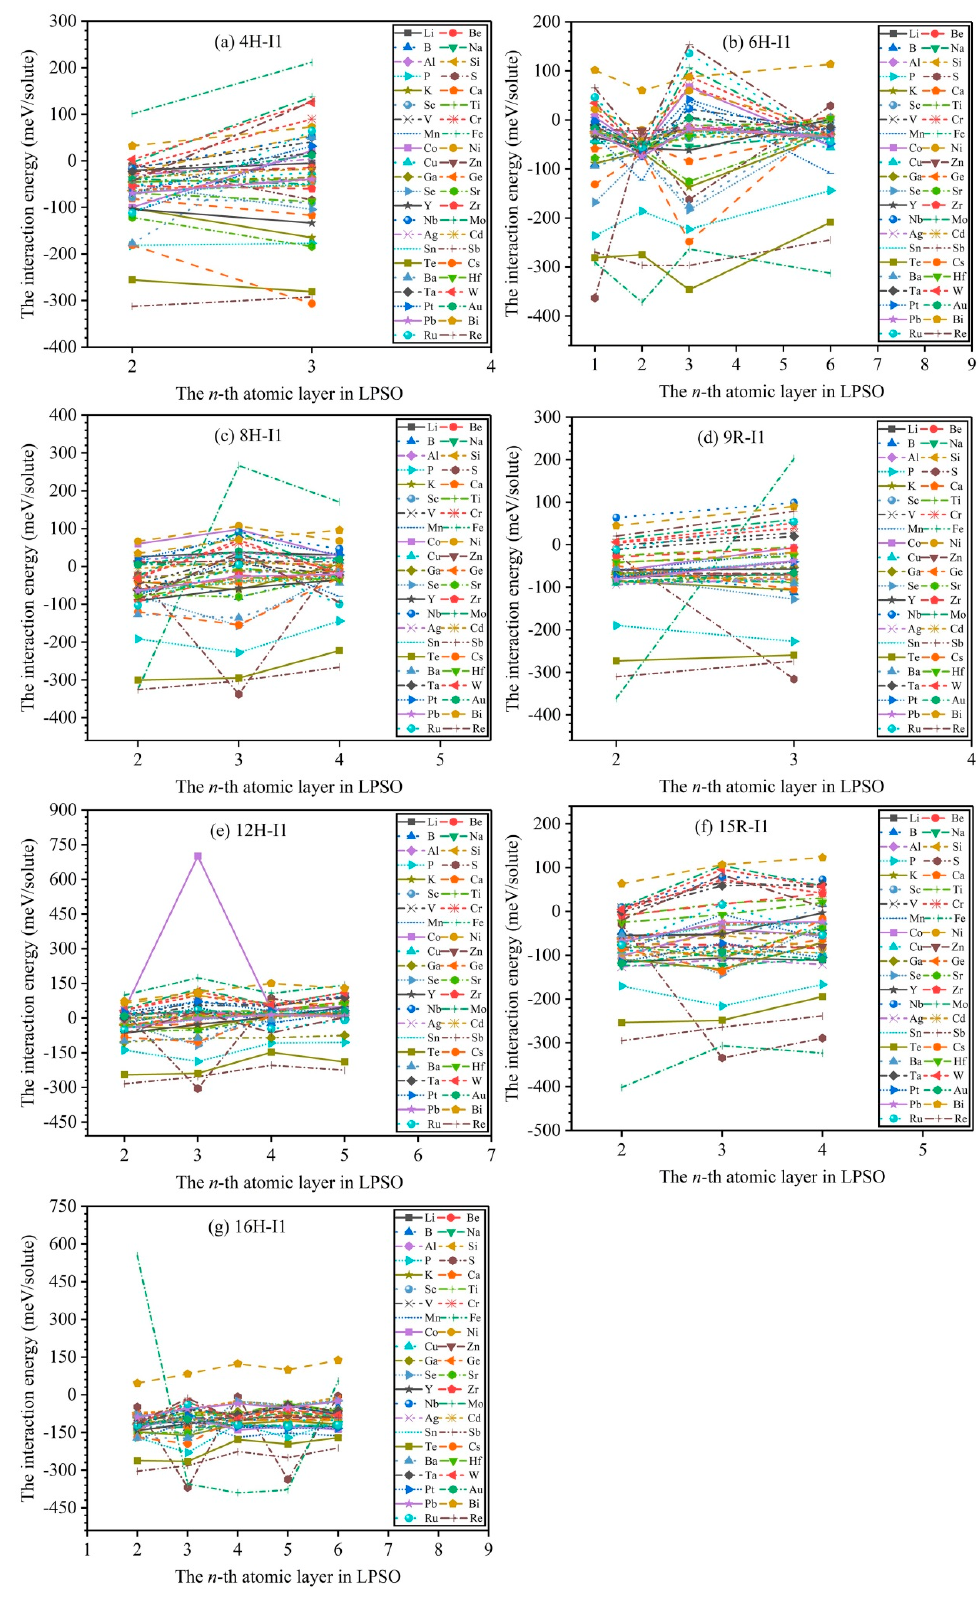
Figure 4. The calculated results of interaction energies between solute atoms in n -th layer and m phases: ( a – g ) denote 4H, 6H, 8H, 9R, 12H, 15R, and 16H phases,